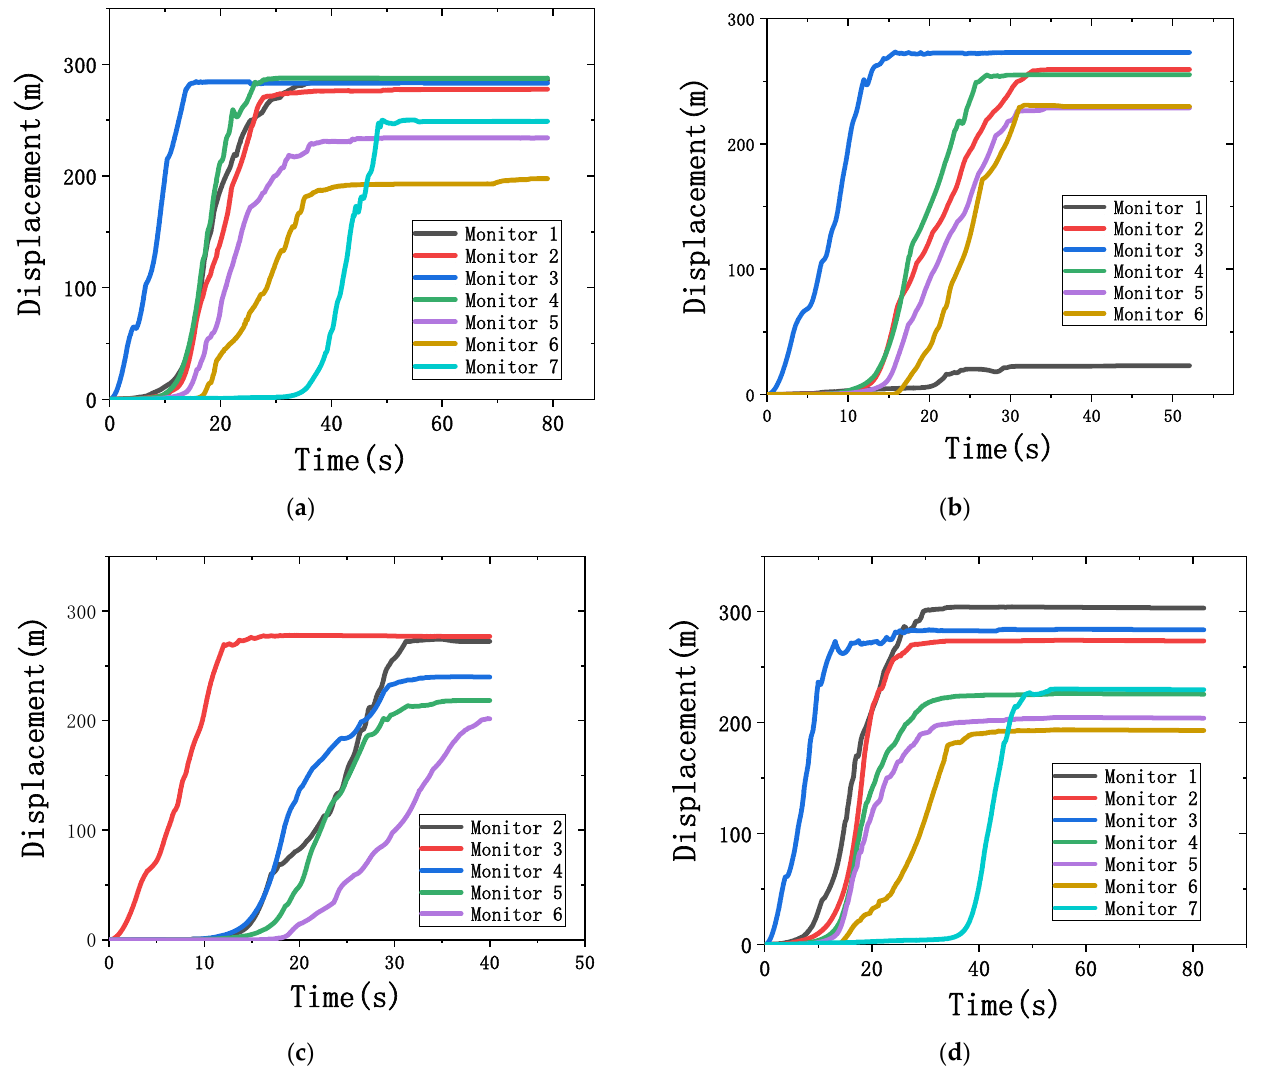
Figure 16. Time history curves of displacement of monitors in the high ‐ steep rock slide process. ( a ) case 1: EW seismic wave; ( b ) case 2: NS seismic wave; ( c ) case 3: UD seismic wave; and ( d ) case 4: EW_NS_UD seismic wave.